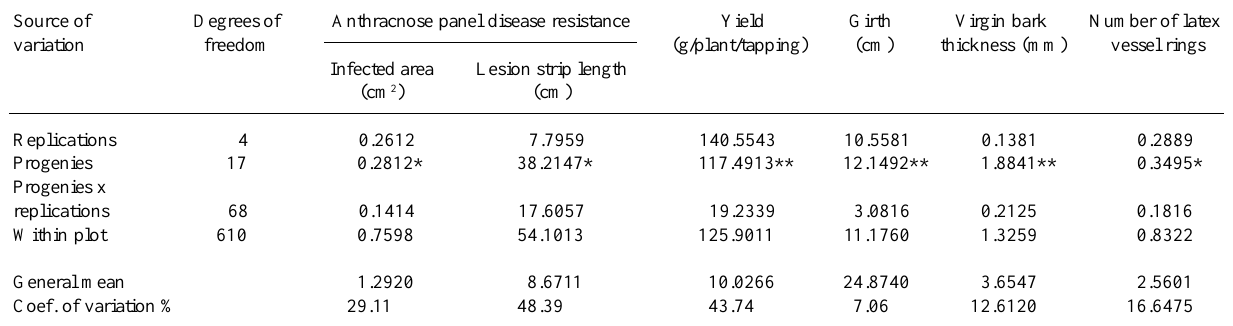
Table II - Results of ANOVA (mean squares) for anthracnose panel canker disease resistance, yield, girth, bark thickness and number of latex vessel rings for open pollinated progenies of rubber tree ( Hevea brasiliensis